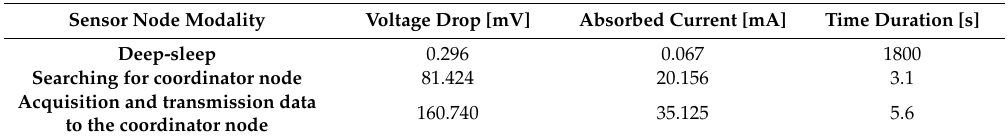
Table 1. Absorbed current and time duration values, extracted by the oscilloscope traces, related to the di ff erent node operating